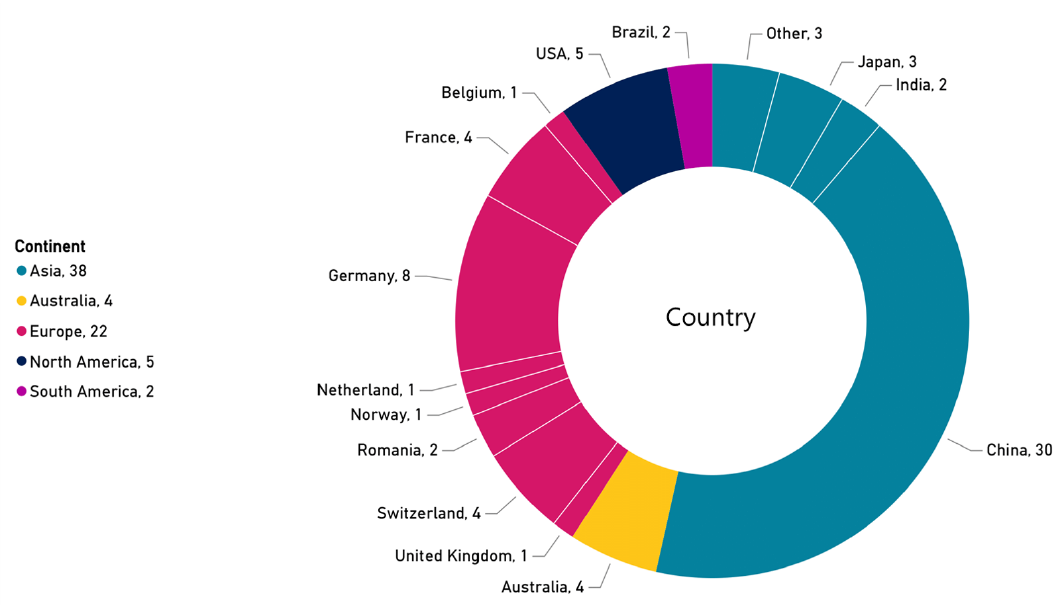
Figure 1. Overview of first author’s affiliation grouped by countries and